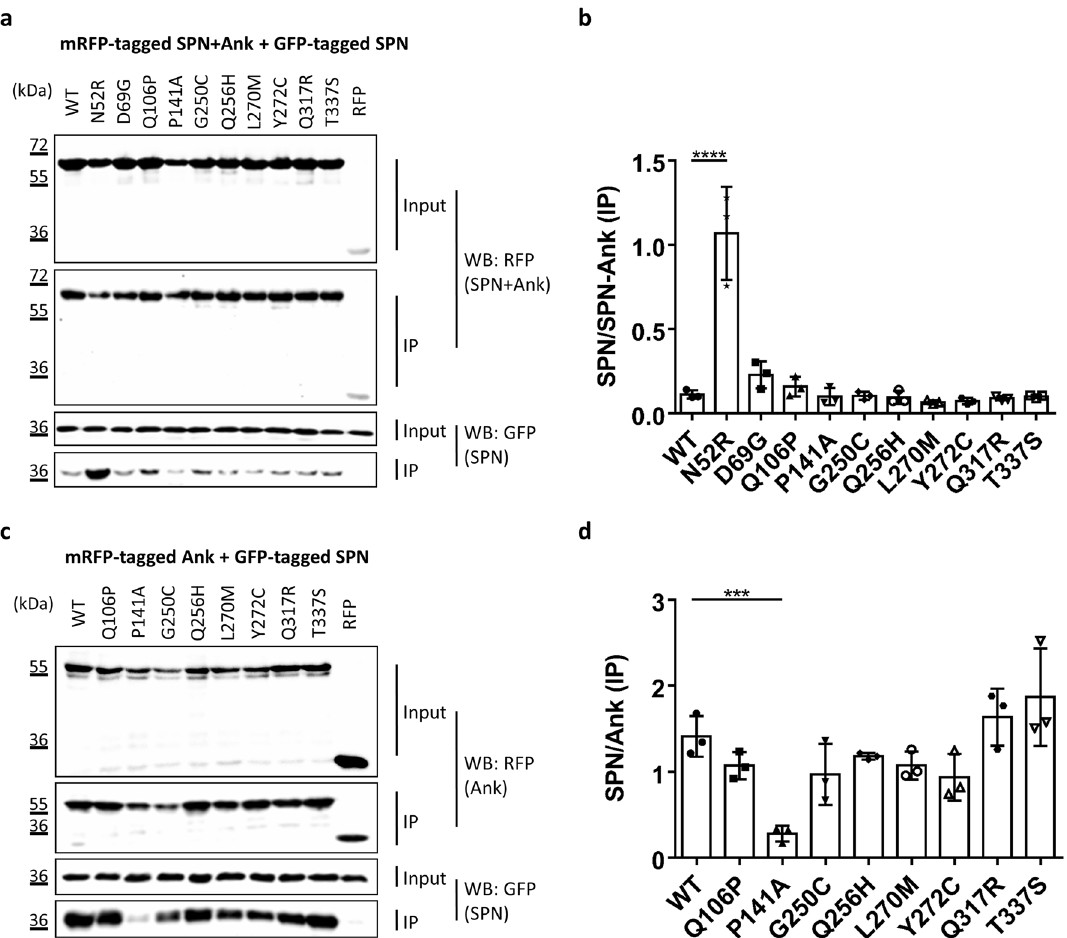
Figure 5. ( a ) RFP-tagged WT and mutant variants of the Shank3 N-terminus (SPN + Ank domains), or mRFP alone, were coexpressed in 293 T cells with the GFP-tagged SPN domain of Shank3. The N52R mutant, which was designed based on the 3D structure of Shank3 to disrupt the SPN − Ank contact, was included as a positive control here. After cell lysis, RFP-tagged proteins were immunoprecipitated using the mRFP-trap matrix. Input and precipitate samples were analysed by Western blotting using mRFP- (upper panels) and GFP-specific antibodies (lower panels). ( b ) Quantitative analysis. Signal intensities in IP samples for GFP-SPN were divided by IP signals for mRFP-Shank3 variants. ****Significantly different from WT, p < 0.0001; ANOVA, followed by Dunnett’s multiple comparisons test. ( c ) The experiment was repeated as in a, however using a Shank3 construct coding for Ank repeats only. d. Quantitative analysis performed as in ( b ). ***Significantly different from WT, p < 0.001; data from three independent experiments; ANOVA, followed by Dunnett’s multiple comparisons